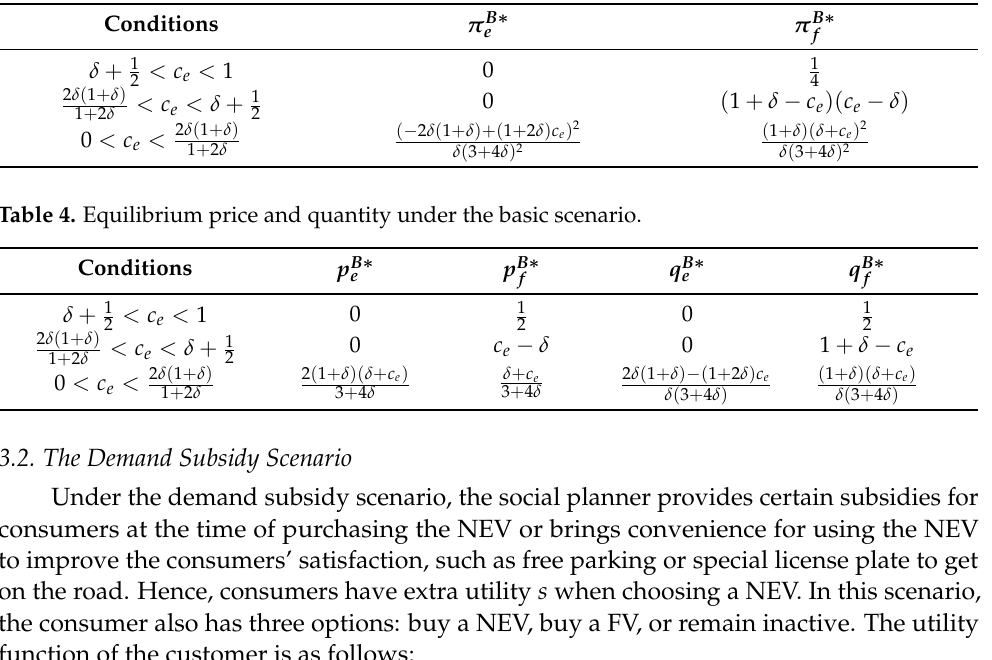
Table 3. Equilibrium profit under the basic scenario.